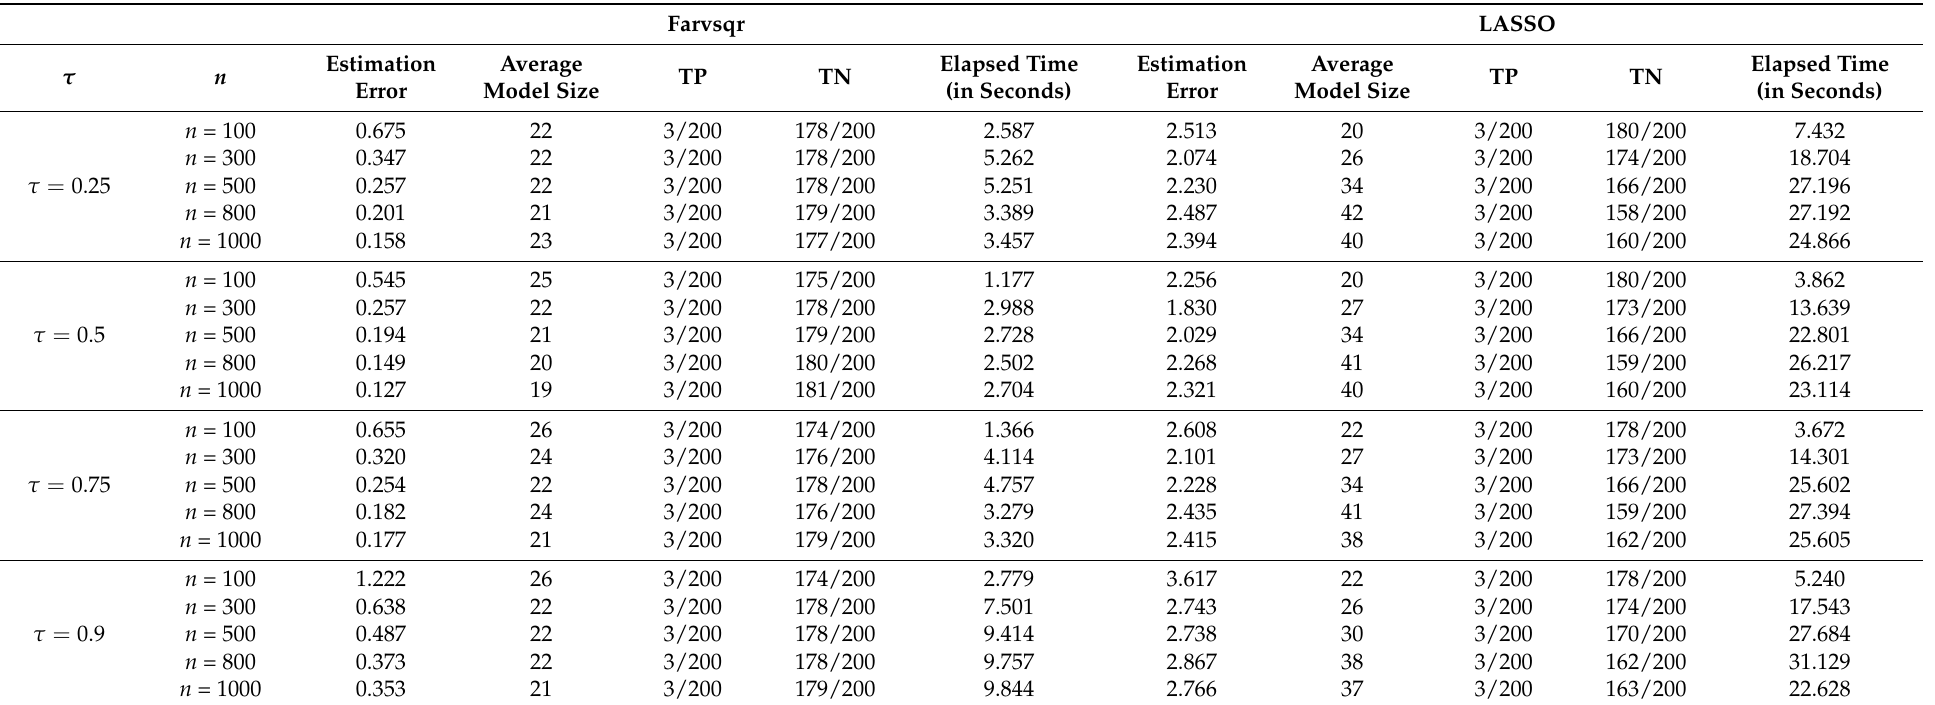
Table 2. The comparison for p = 200, t 2 with the factor model. Farvsqr